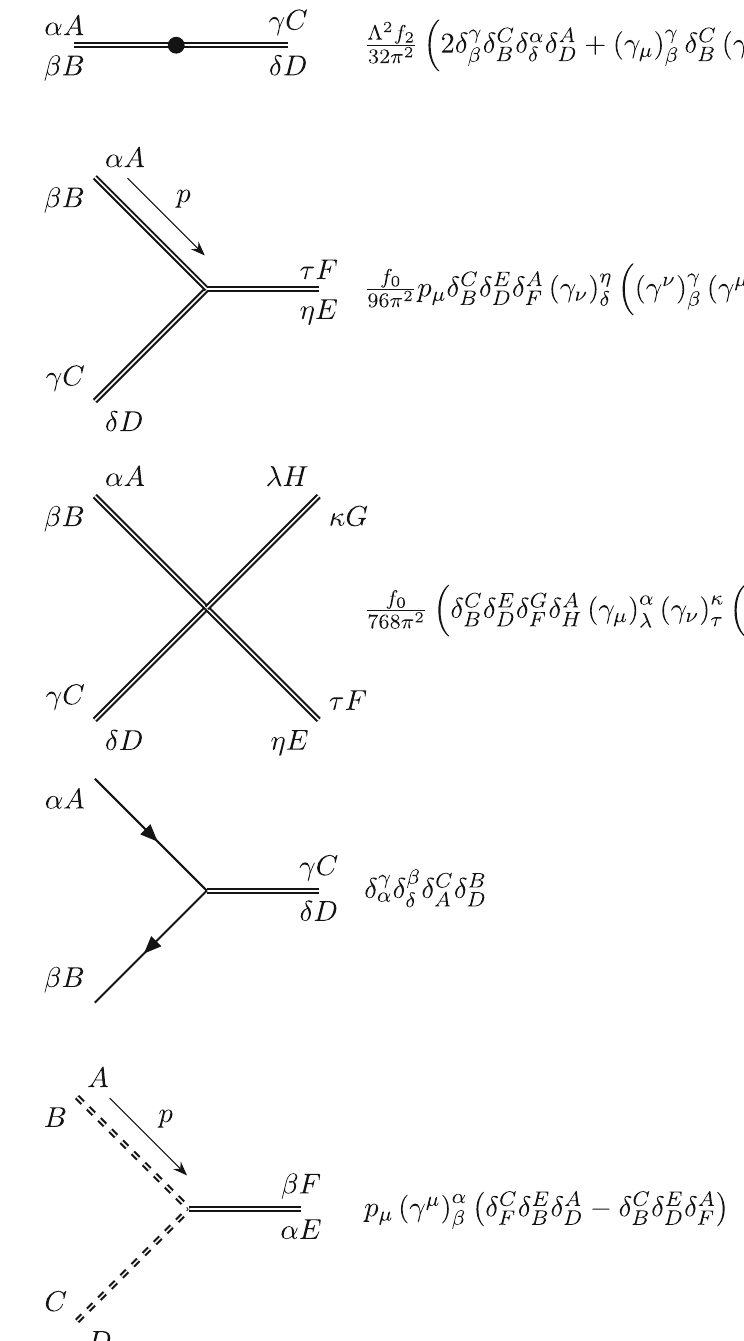
Fig. 2 Feynman rules for the vertices